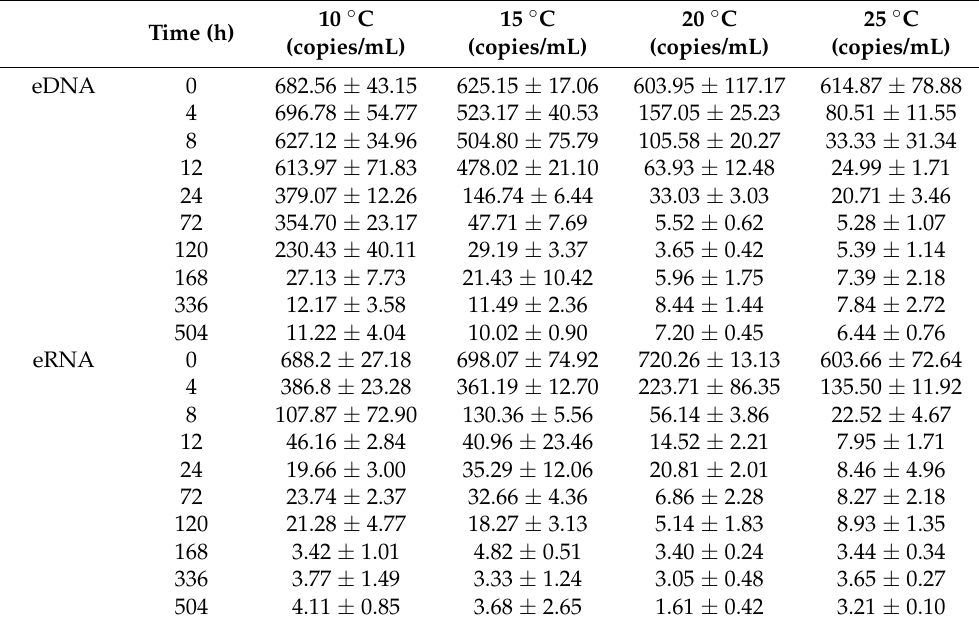
Figure 4. Initial concentration (copies/mL; N 0 ) of Fenneropenaeus chinensis eDNA and eRNA. Table 2. Average concentration of Fenneropenaeus chinensis eDNA and eRNA at four temperatures (10, 15, 20 and 25 ◦